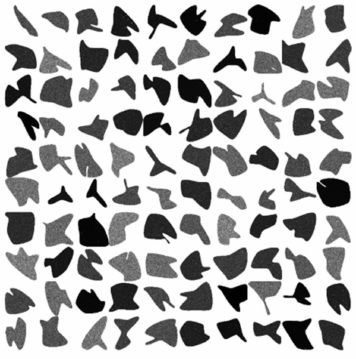
Figure 5. B é zier–Gaussian random pseudo-defects.